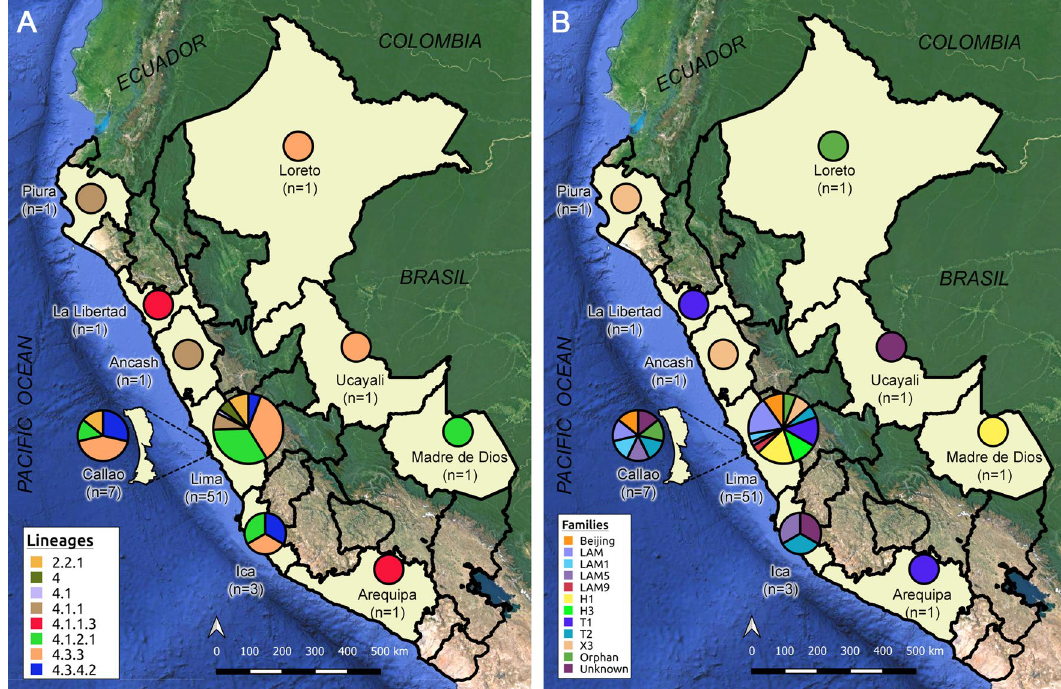
Figure 1. Lineages and family classification of Peruvian XDR-TB strains. Distribution of lineages, sublineages ( A ) and genetic families ( B ) throughout the entire Peruvian territory. The number of XDR-TB strains (n) from each region is specified. The size of the circles was set using the scale ‘Log 10 (n + 1)’. Maps were created using QGIS v3.14.15 (https:// www. qgis.